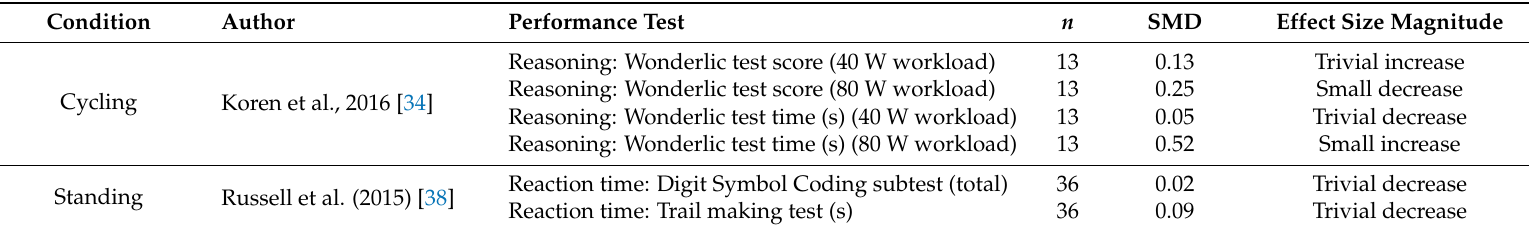
Table 5. Effect of active workstation use on reasoning and reaction time.